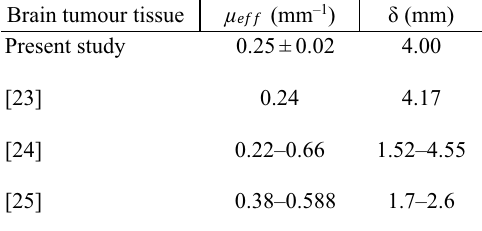
Table 3. Comparison of the effective attenuation coefficient and penetration depth values obtained in this study and other studies at 630